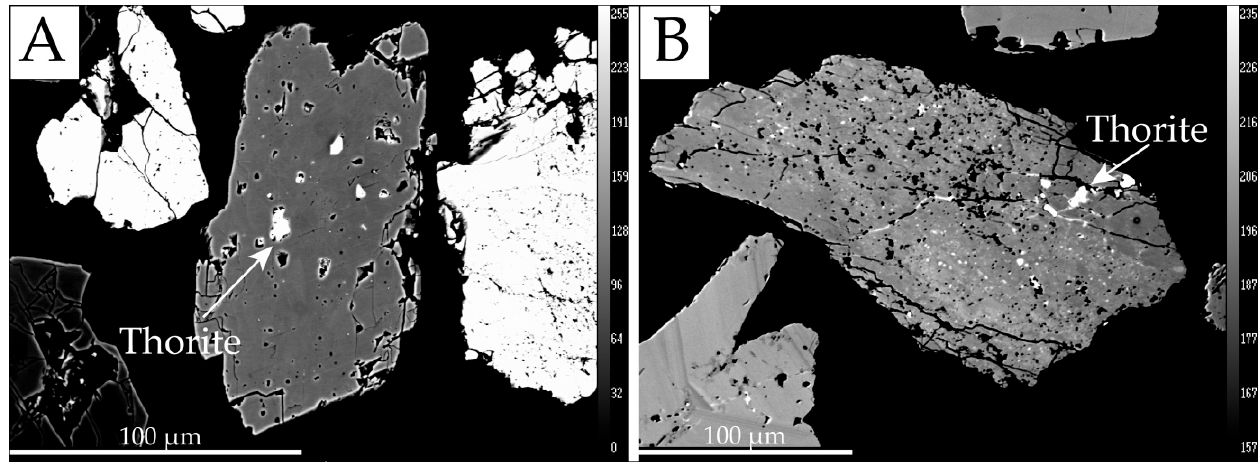
Figure 8. ( A ) Monazite with thorite inclusions; ( B ) Xenotime pore space filled with thorite. SEM-BSE observations.